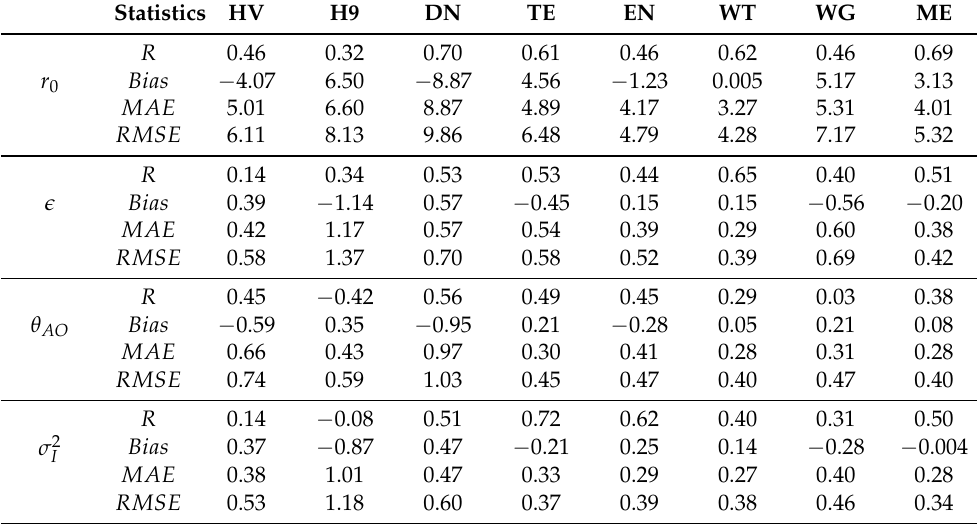
Table 4. ECACN integrated astronomical parameters statistics (@ λ = 550